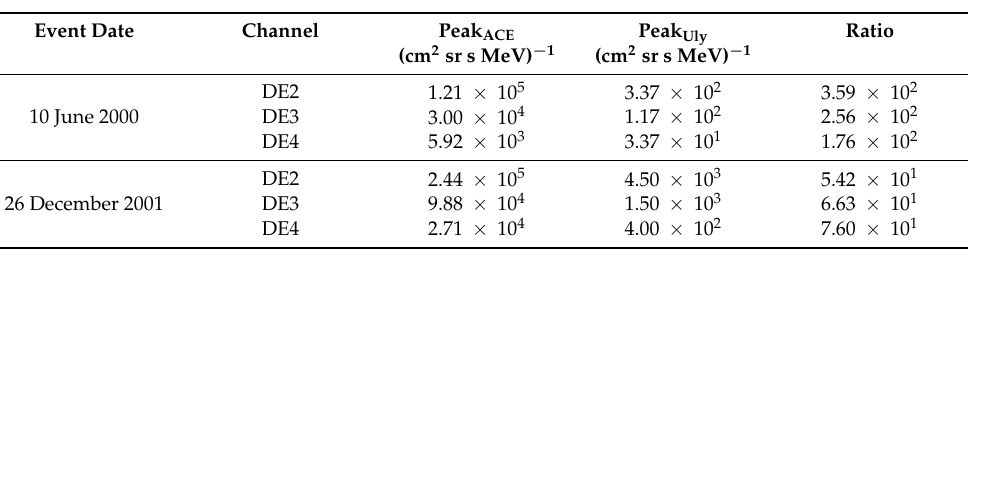
Table 2. Peak intensities of ACE and Ulysses observations and their ratios in different energy